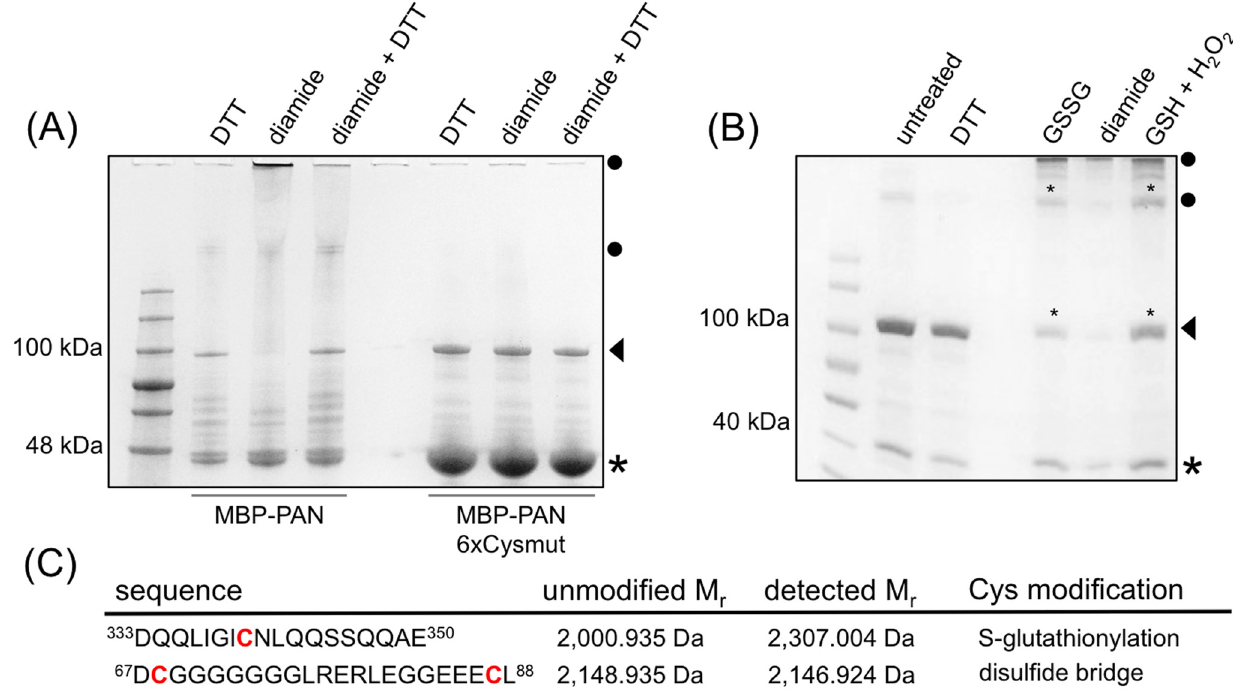
Fig 3. Analysis of posttranslational PAN modifications. (A) Non-reducing SDS-PAGE analysis of MBP-PAN and MBP-PAN6xCysmut proteins. Proteins were incubated with 20 mM DTT, 2 mM diamide or with 2 mM diamide followed by 20 mM DTT. Triangles indicate MBP-PAN (~90 kDa) and MBP-PAN6xCysmut (~90 kDa) proteins and the asterisk marks MBP (~43 kDa). Dimerized and oligomerized fusion proteins are labeled with full circles. (B) Non-reducing SDS-PAGE analysis for identification of posttranslational cysteine modifications. MBP-PAN protein was incubated under different conditions (20 mM DTT, 2 mM diamide, 10 mM GSSG and 5 mM GSH/5 mM H 2 O 2 ) and interesting bands, marked with an asterisk, were further processed for MS analysis. (C) Posttranslational PAN cysteine modifications as determined by the difference between predicted, unmodified and detected MS mass